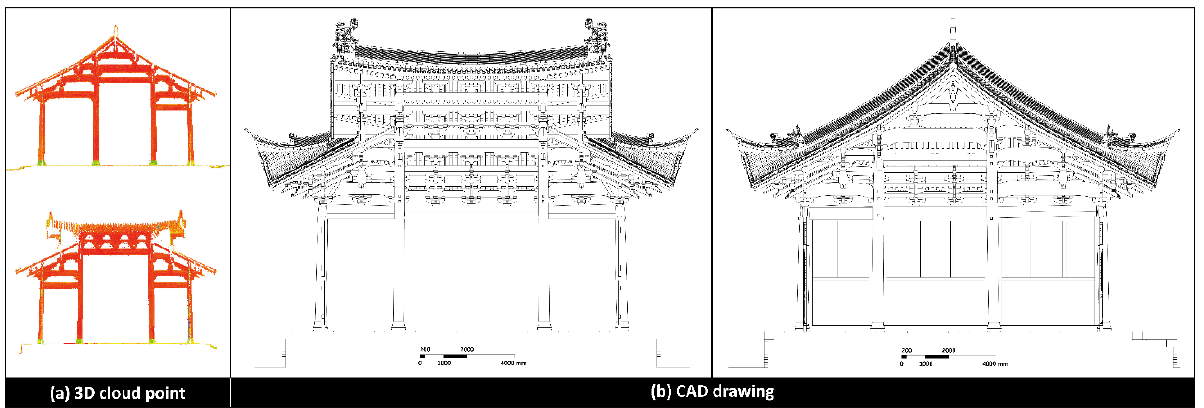
Figure 5. Three-dimensional cloud points and the CAD drawing of the main hall of the Tian-ning Temple. ( a ) 3D cloud point; ( b ) CAD